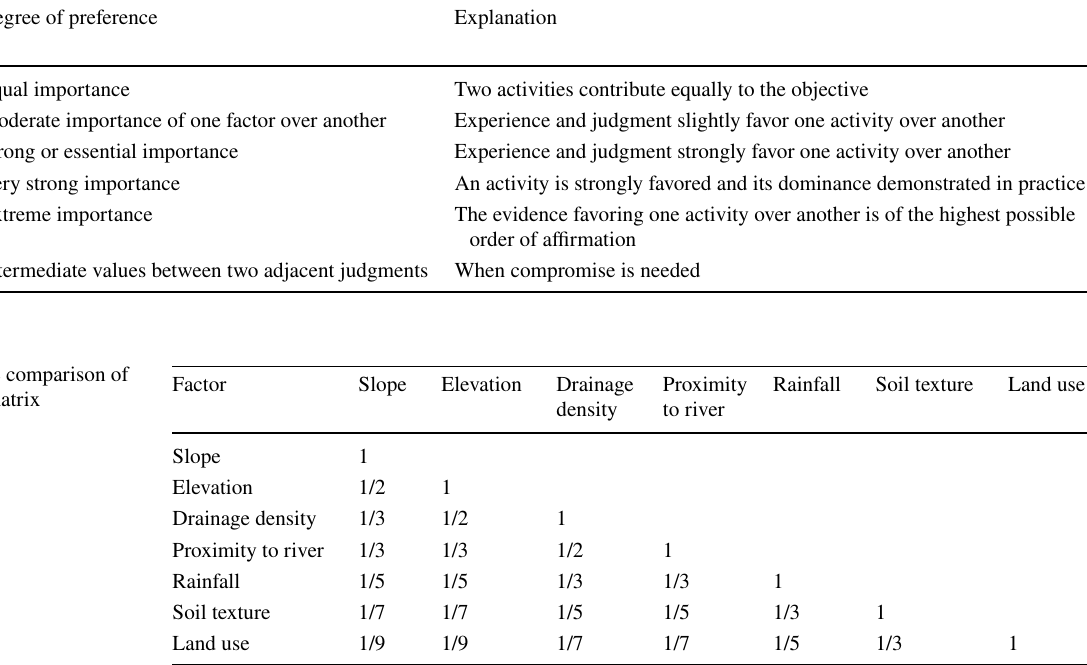
Table 1 Satty’s scale of relative importance (Saaty 1980; Saaty and Vargas 1991)